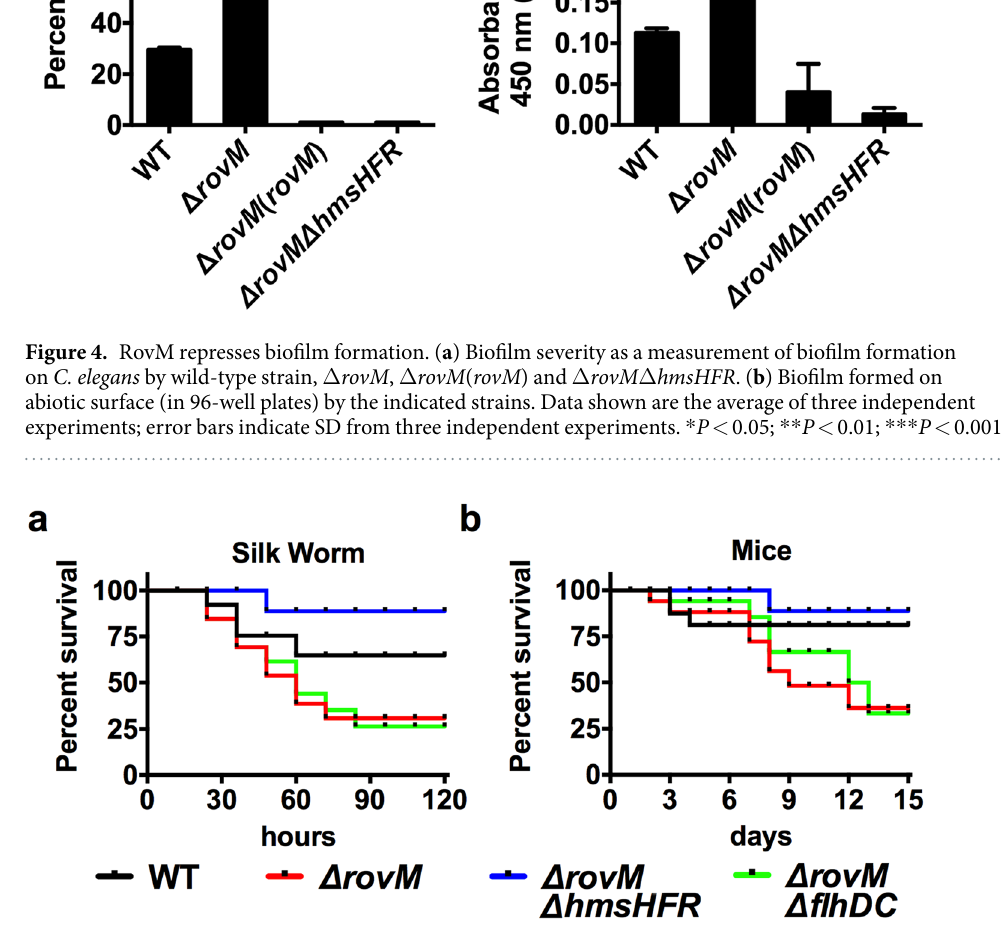
RovM attenuates bacterial virulence by repressing hms expression. RovM was previously reported to attenuate virulence by repressing the expression of rovA , which controls expression of virulence genes in Y. pseudotuberculosis 32 . Since biofilm formation is crucial for bacterial virulence, we hypothesized that the effect of RovM on Y. pseudotuberculosis virulence was also mediated by regulation of hms . We thus tested bacterial vir- ulence by injecting larval silkworms with the wild-type strain, Δ rovM , Δ rovM Δ hms , and Δ rovM Δ flhDC . The Δ rovM mutant caused more than 60% mortality within 72 h of inoculation. Larvae infected with mutants lacking rovM and flhDC survived at a similar rate, while the wild-type bacteria were less virulent. Notably, mutations in both hms and rovM caused near-complete loss of the virulence to larvae (Fig. 5a), implying that regulation of hms is essential to the virulence of Δ rovM . This result was confirmed by orogastrically inoculating relevant bacterial strains into C57BL/6 mice (Fig. 5b). Together, these results indicate that in addition to repressing the expression of rovA , RovM attenuates bacterial virulence by repressing hms expression and biofilm formation. RovM coordinates the planktonic/biofilm state transition.